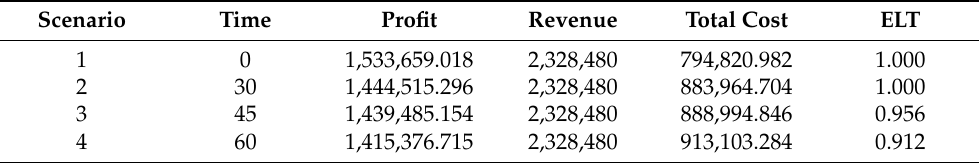
Table 2. The supply chain performance with factory disruptions.